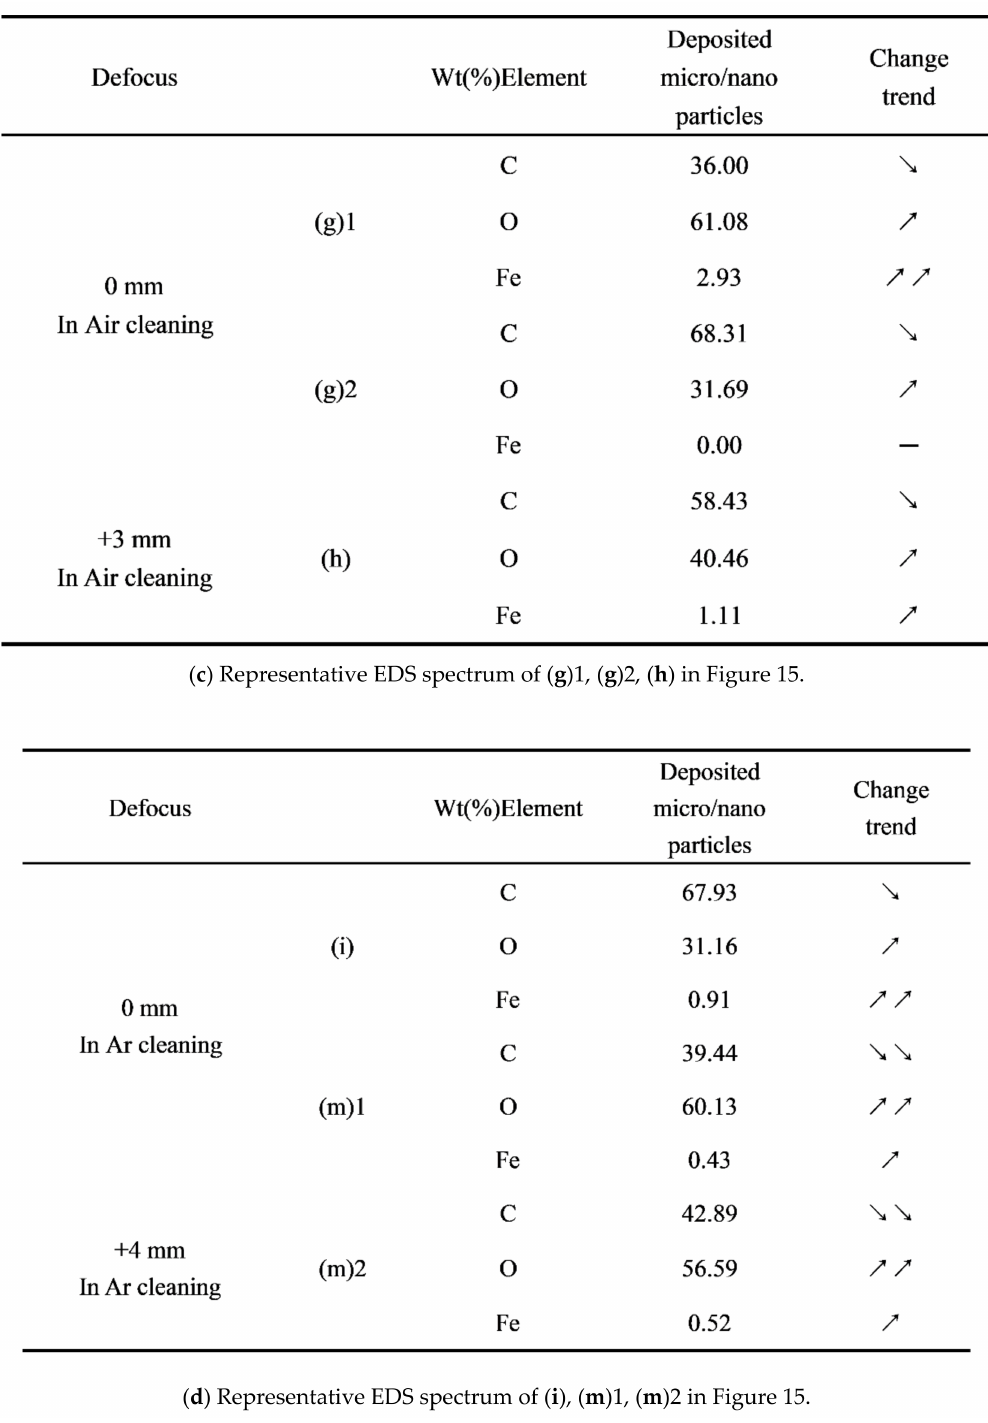
Figure 16. Representative EDS spectrum of ( a – e ), ( g )1, ( g )2, ( h ), ( i ), ( m )1, ( m )2 in Figure